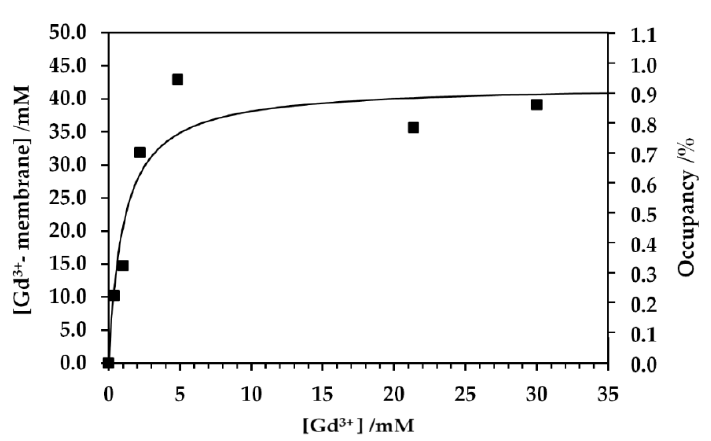
Figure 7. Concentration of Gd 3 + ion binding with membrane of E. coli cells, [Gd 3 + - membrane], and the fractional occupancy of the binding site on cell membrane Y as a function of concentration of extracellular Gd 3 + ion [Gd 3 + ] are shown by closed squares. Experimental results were fitted to the function [Gd 3 + - membrane] = S ([Gd 3 + ] / K d ) / (1 + ([Gd 3 + ] / K d )) where S is the concentration of total binding site S = [free cell membrane] + [Gd 3 + - membrane]. The percent occupancy is calculated from [Gd 3 + - membrane] × 100 / S .